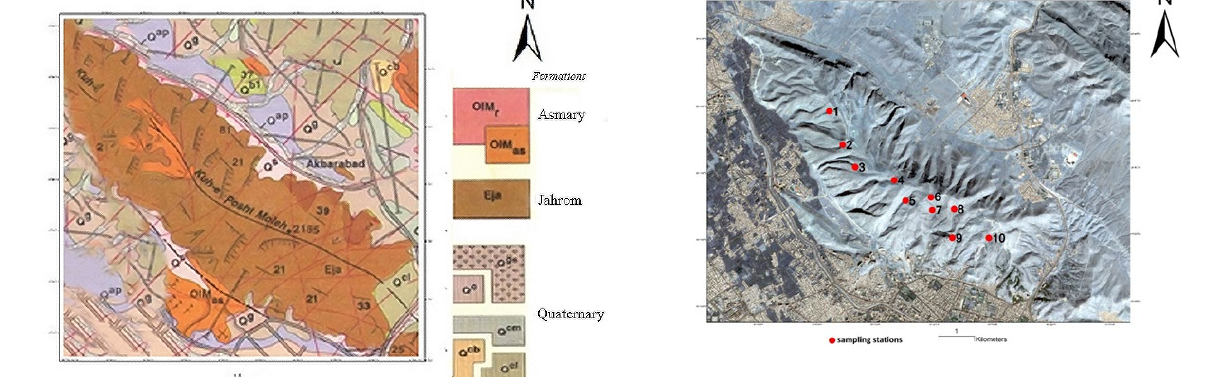
Figure 3. location of sampling stations in sentinel 2